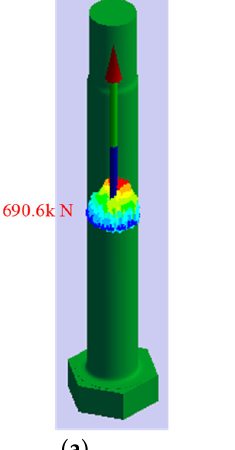
Figure 12. Stress distribution under design load: ( a ) bolt and ( b ) flange.